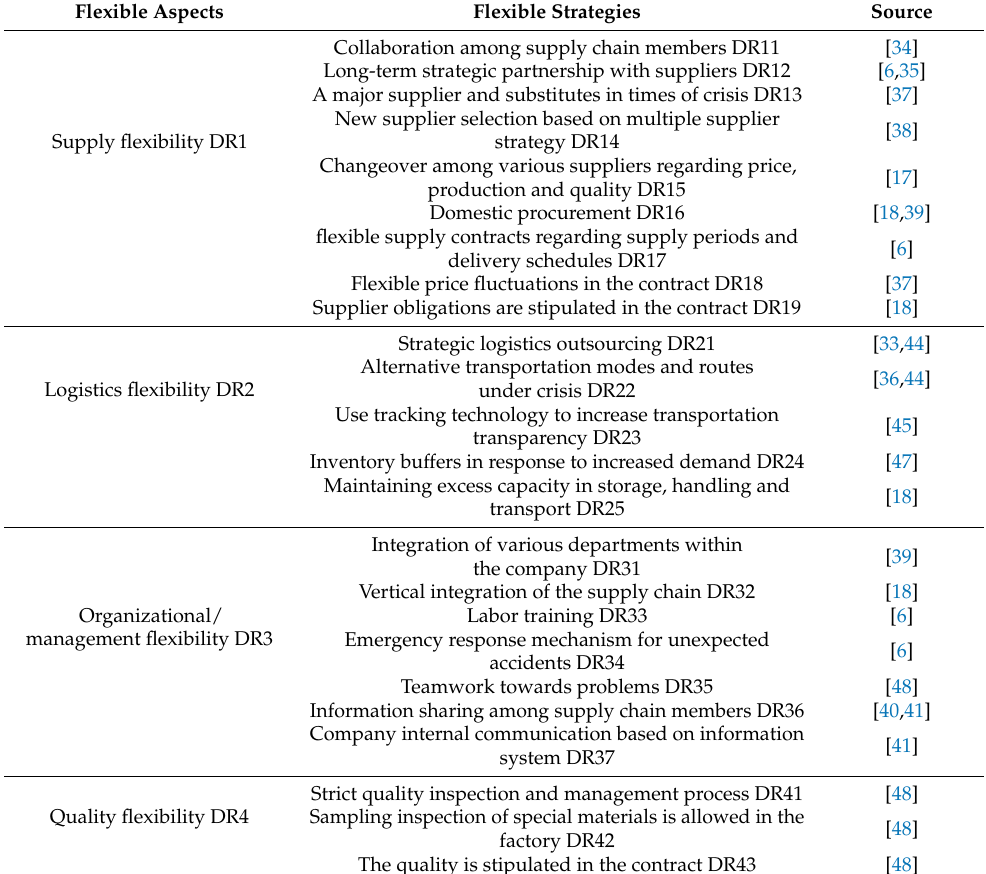
Table 3. DRs for a supply chain with